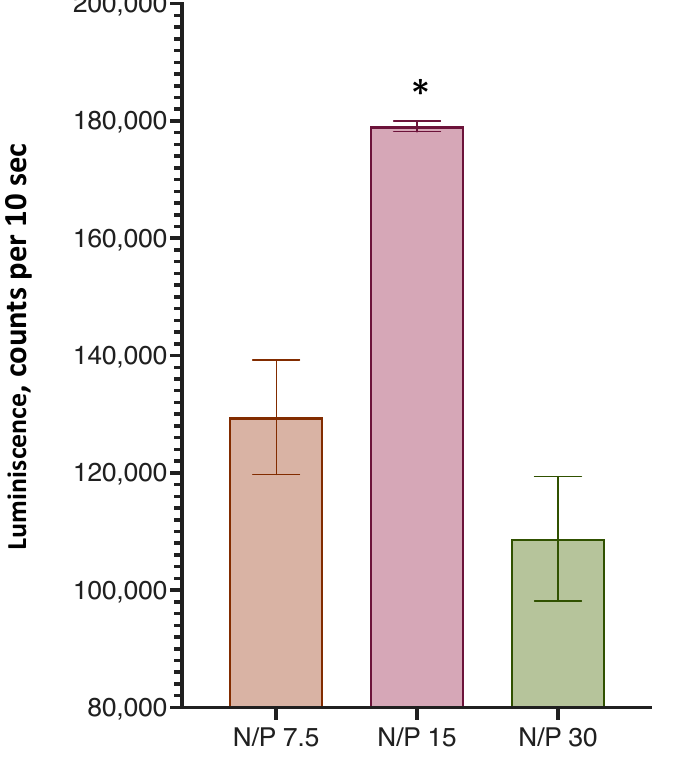
Figure 8. Transfection efficiency of HEK 293T cells with lipoplexes with different N/P ratios. *, A statistically significant difference from samples with N/P ratios of 7.5 and 30, p < 0.05. Incubation time was 24 h, n = 3.